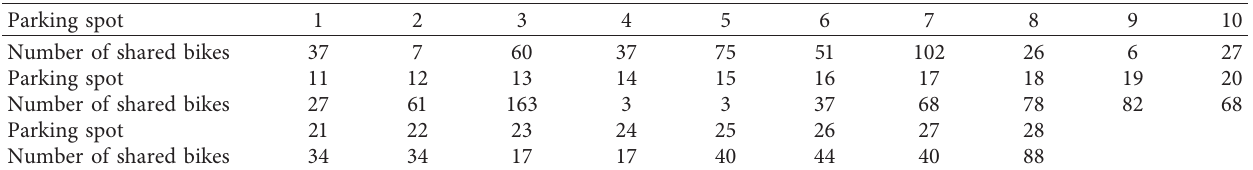
Table 5: Number of optimized parking spots and corresponding shared bikes.